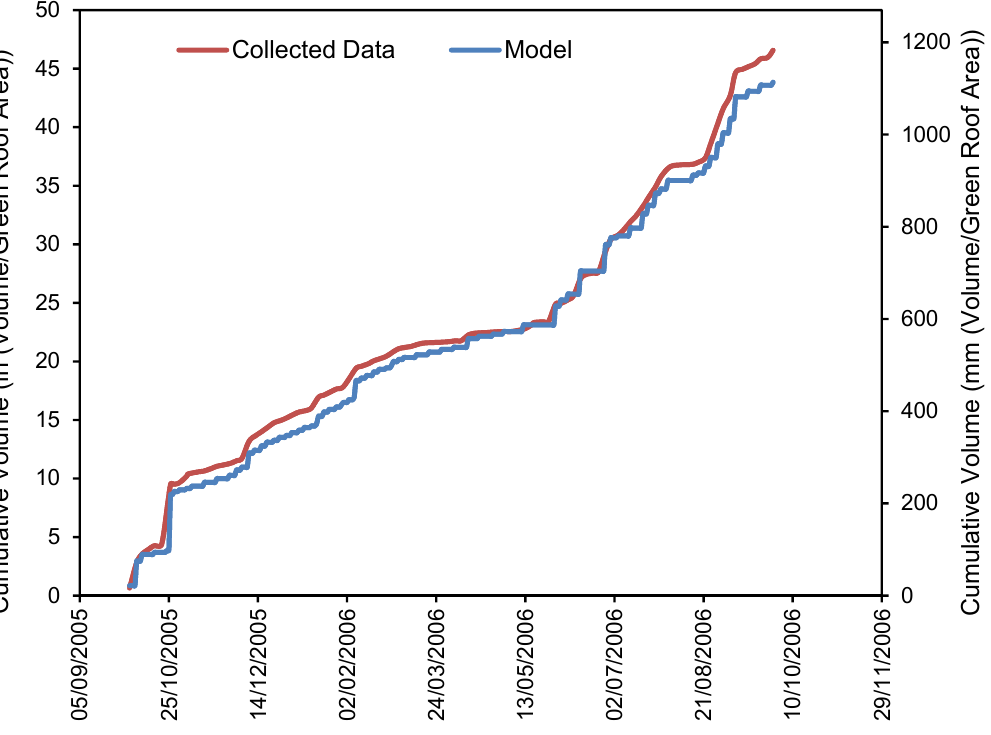
Figure 6. Cumulative filtrate volume vs . time for modeled data and experimental chambers data from Hardin [10].